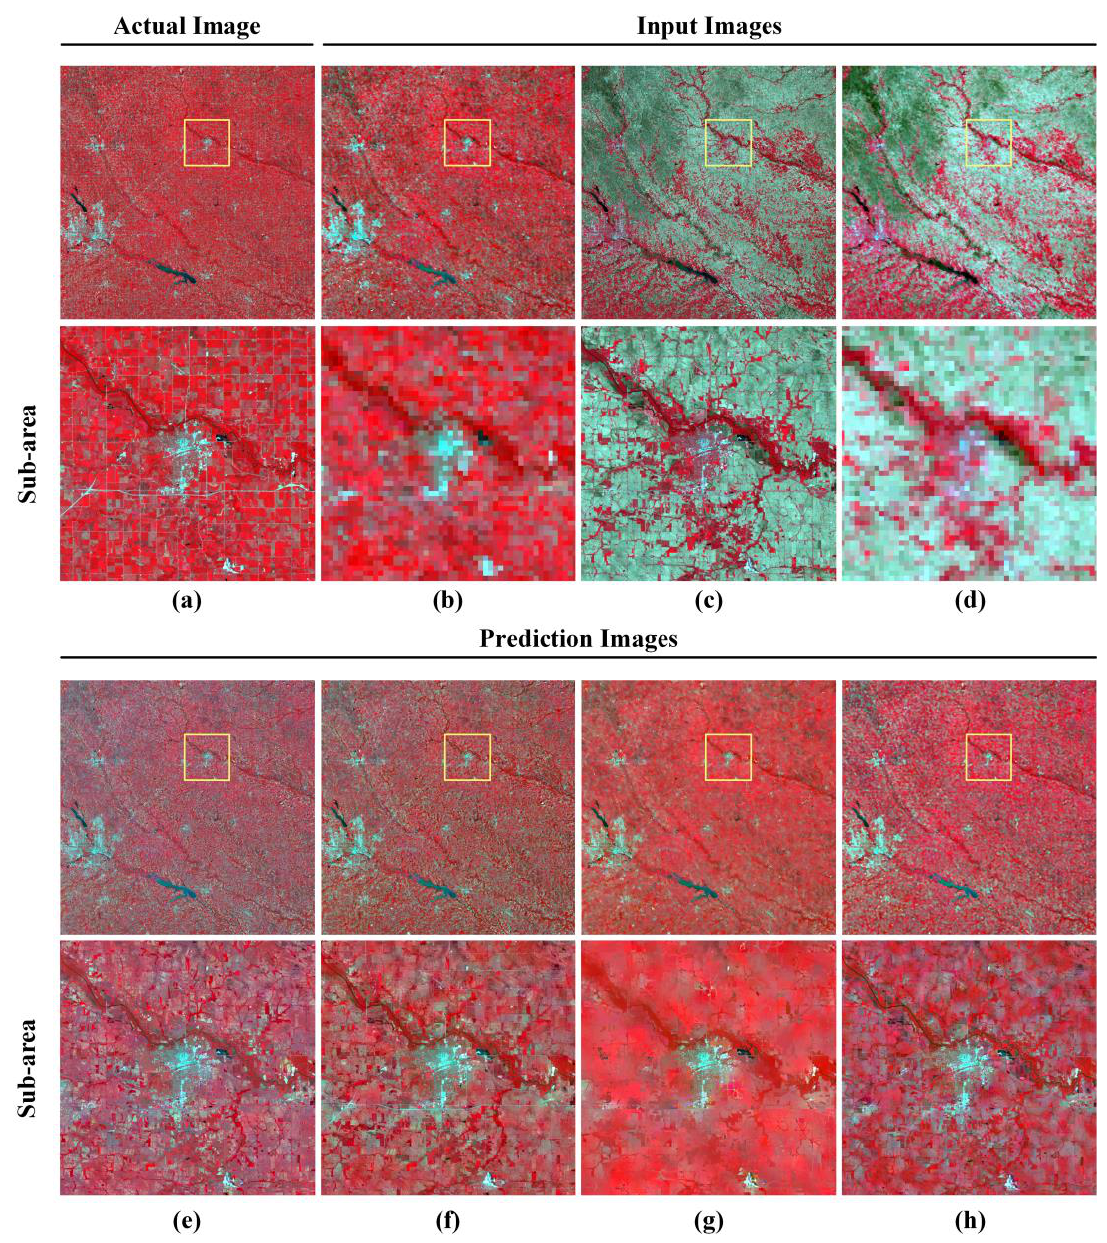
Figure 7. Visual comparison of the prediction results of different STF methods for the CI site. ( a ) Actual image. ( b ) MODIS image at the prediction date. ( c ) Landsat image at the base date. ( d ) MODIS image at the base date. ( e ) STARFM. ( f ) FSDAF. ( g ) Fit-FC. ( h ) HDLSFM.